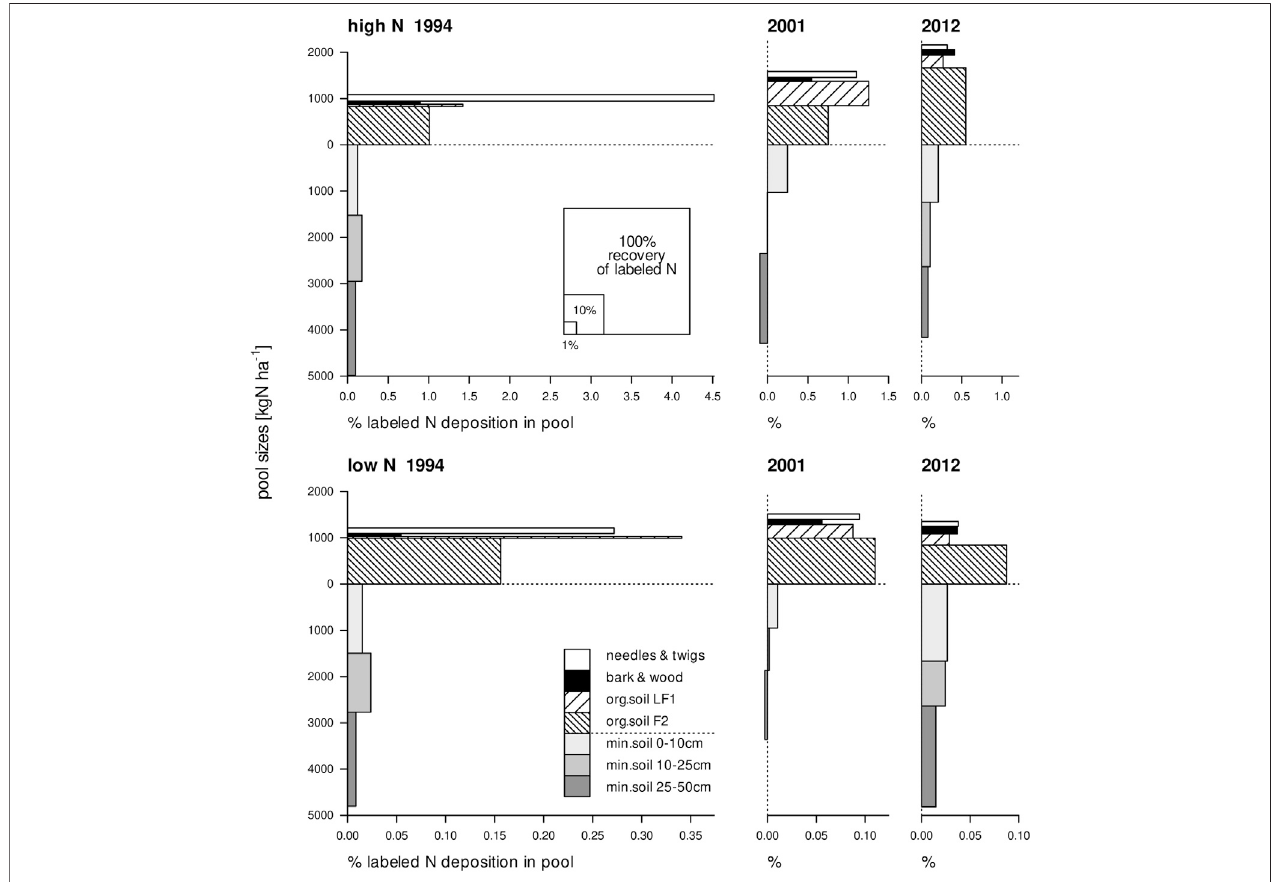
FIGURE1| SizeofeachNpoolagainstthepresenceoftracerinthepoolinhighandlowNdepositionplotsinaScotspineforest,one,eightandnineteenyearsafter labeling. The area of each rectangle represents the recovery of 15 N in that pool (expressed as the proportion of applied label, see legend in upper left panel). Please note that the x -axes for the high and the low N deposition treatments have different scales. Redrawn from Wessel et al. (2021).